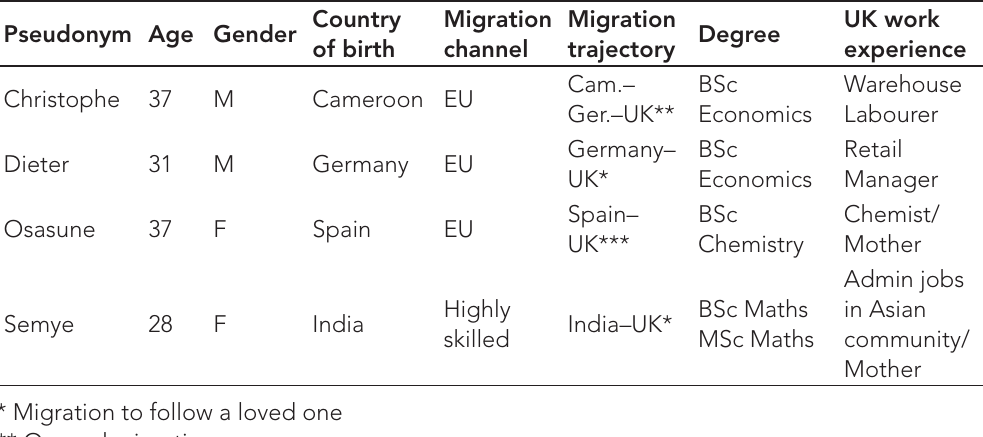
Table 1: Table of Participant Information Pseudonym Age Gender